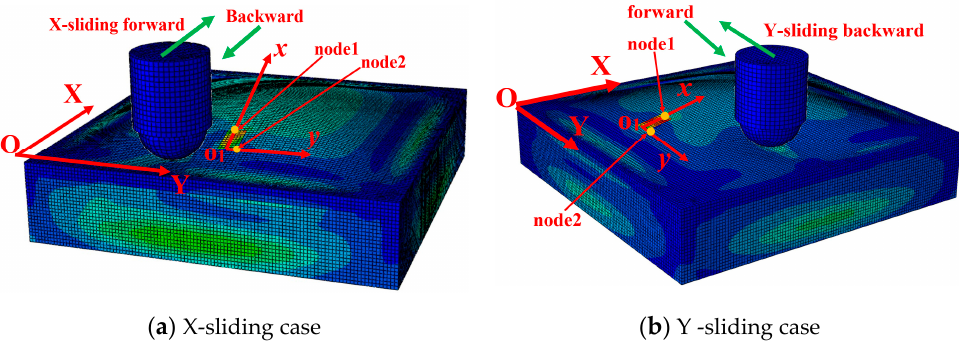
Figure 4. Dynamic simulation of soft active tactile sensing system. ( a ) Indenter is displaced 0.5 mm toward the skin, then is forced to slide along X axis with forward and backward directions. ( b ) Indenter is displaced 0.5 mm toward the skin, then is forced to slide along Y axis with forward and backward directions.